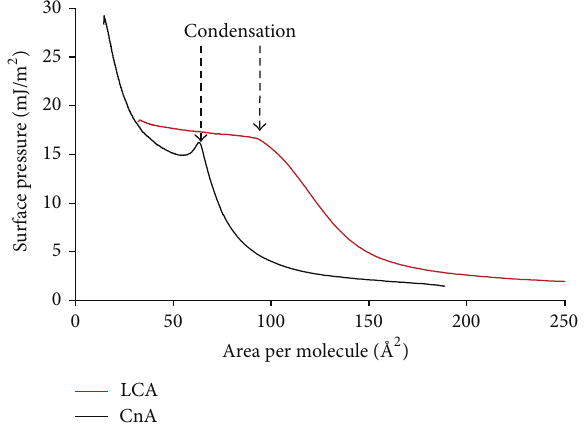
Figure 3: Compression isotherms of CnA and LCA measured on 3 M NaCl at pH = 1.2 aqueous subphase at 25 ± 0.1 ∘ C. Surface pressureunitisexpressedinmJ/m 2 insteadofthecommonlyapplied mN/m.